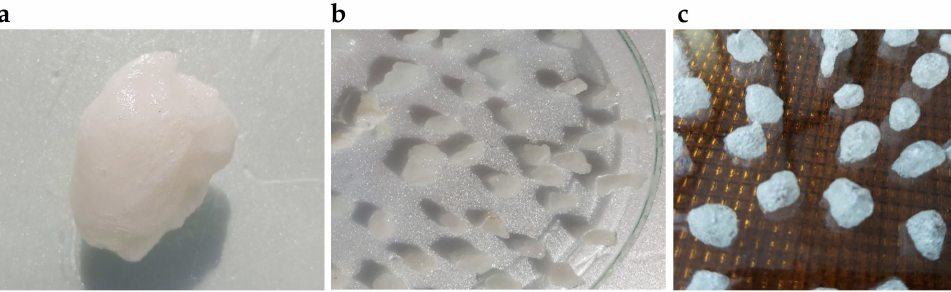
Figure 13. Illustration of synthetic procedure for preparation of carboxymethyl starch (CMS).